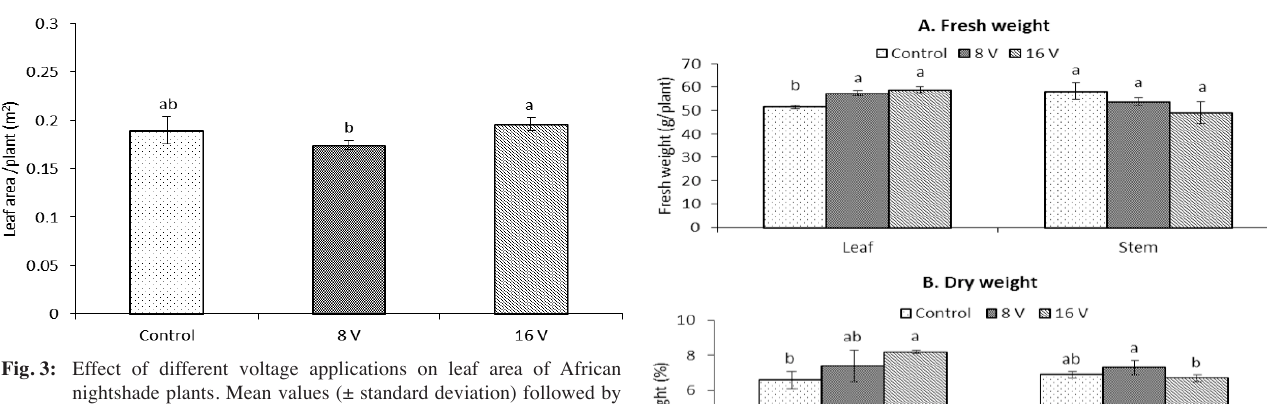
Days after treatment application